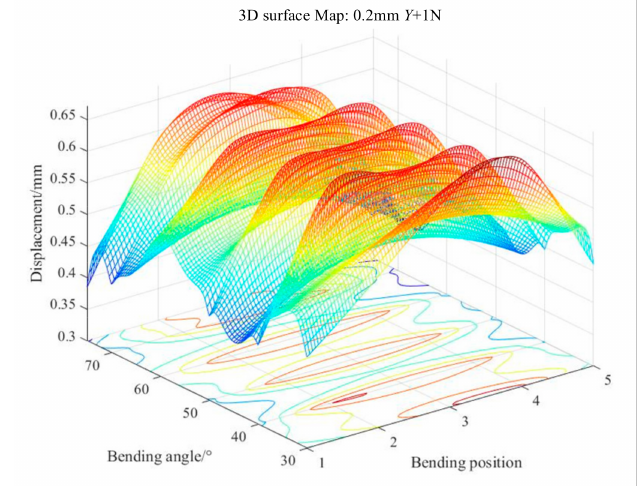
Figure 7. Displacement caused by the application of 1 N in the Y -direction.